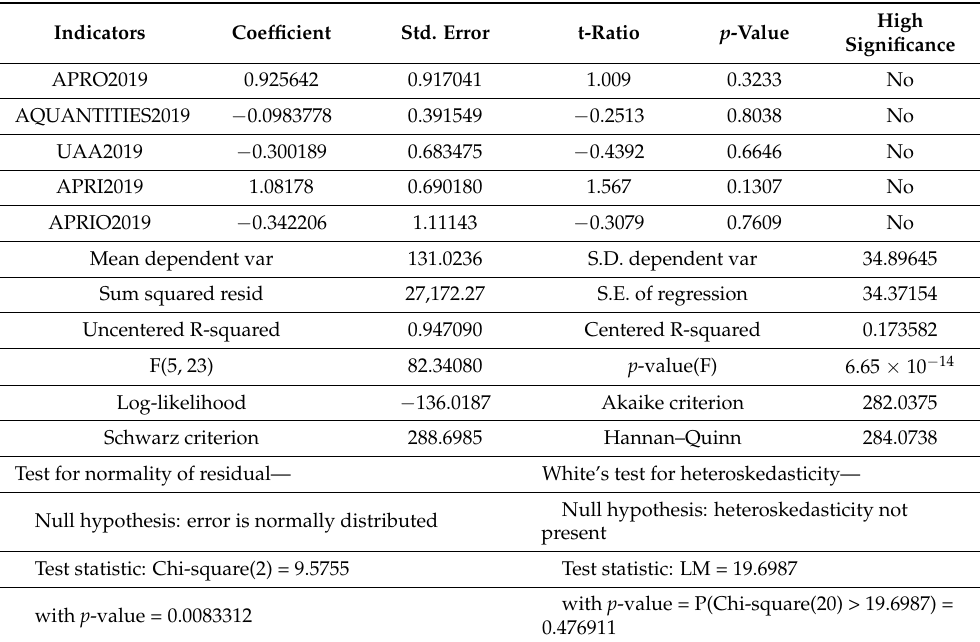
Table 9. Model 2019: OLS, using observations 1–28 (Dependent variable: AINCOME2019).